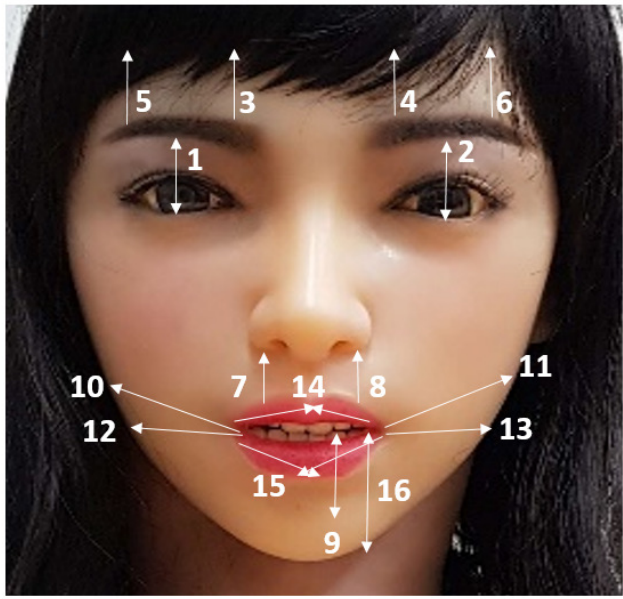
Figure 2. Gene position in a chromosome.